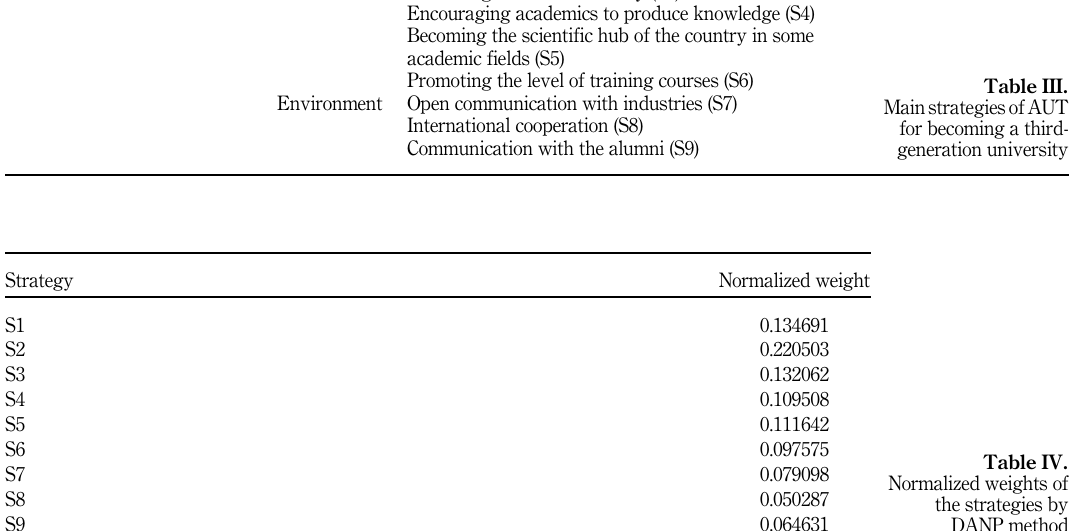
Table IV. Normalized weights of the strategies by DANP